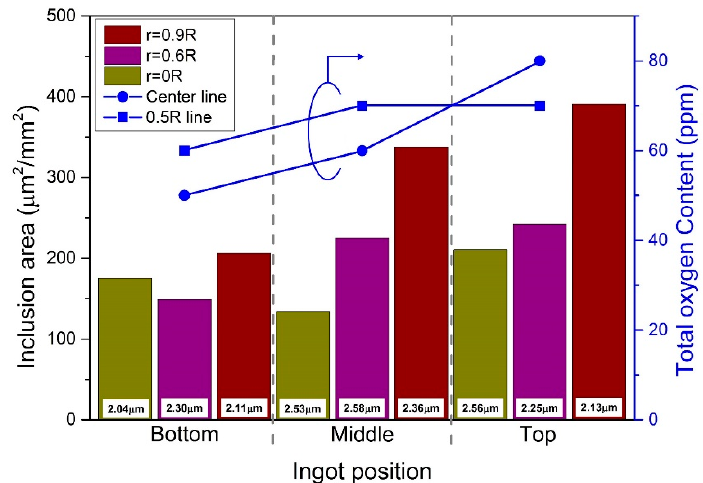
Figure 8. Evolution of total are of nonmetallic inclusions along radial direction at different heights of ESR ingot. Only 1–5 μ m inclusions are counted.